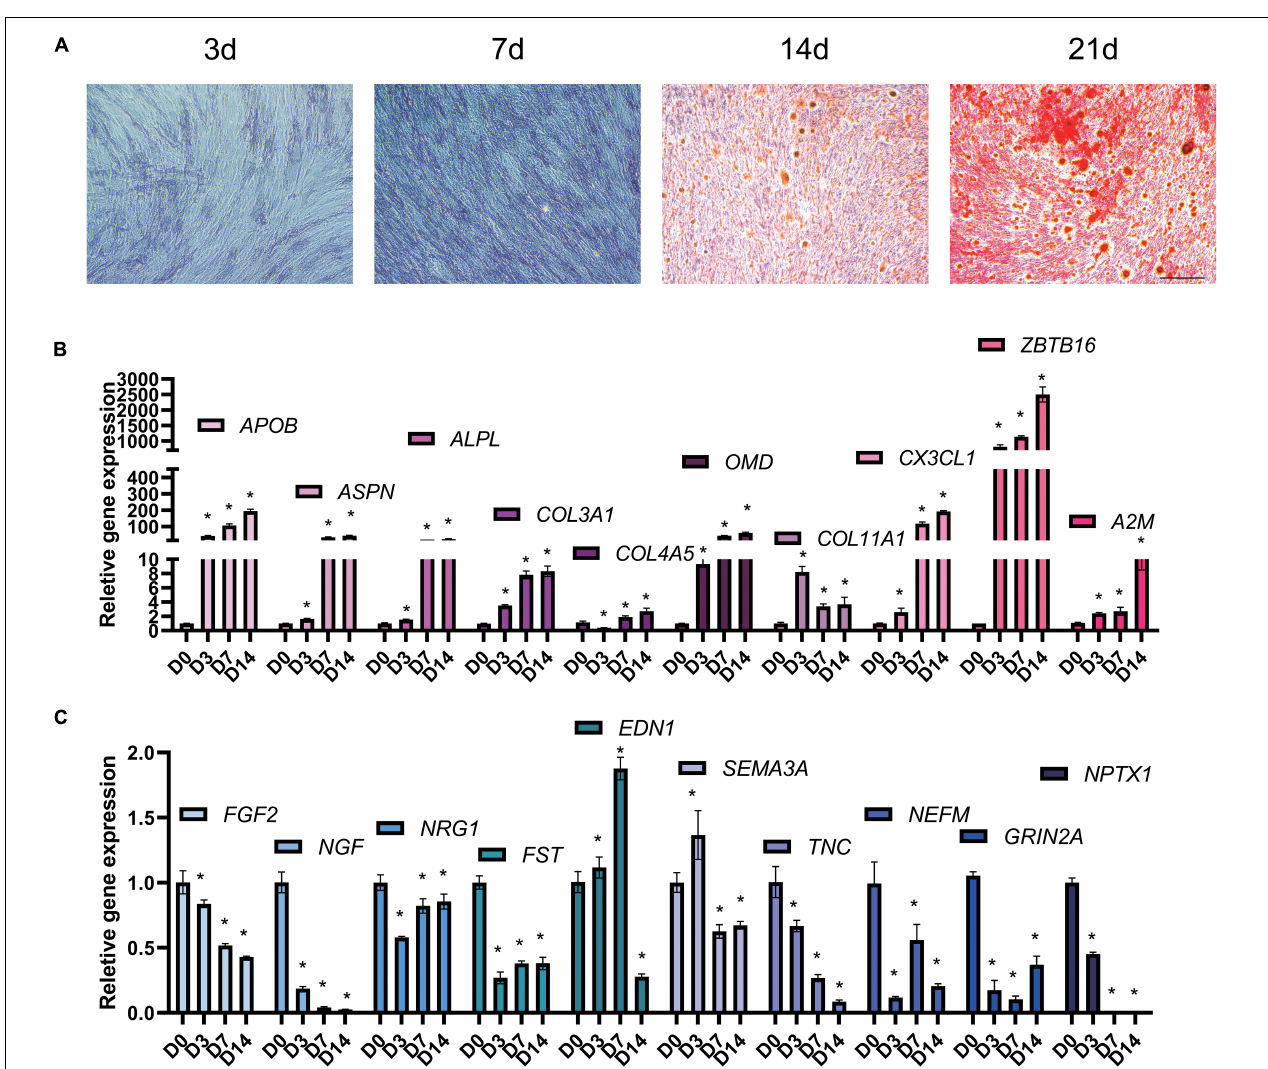
FIGURE 5 | Hub genes change during osteogenic differentiation of PDLSCs in vitro . PDLSCs cells were cultured in osteogenic induction medium for 0, 3, 7, 14 days and tested by qPCR. (A) Representative microscope pictures show results of ALP staining at 3 and 7 days, and the results of Alizarin Red staining at 14 and 21 days. ALP and ARS staining were used to prove that the process of osteogenic differentiation was successful. (B) qPCR results shows up-regulated hub genes APOB, ASPN, ALPL, COL3A1, A2M, COL4A5, OMD, COL11A1, ZBTB16, and CX3CL1 (C) down-regulated hub genes FGF2, NGF, NRG1, FST, EDN1, SEMA3A, TNC, NEFM, GRIN2A, and NPTX1 during osteogenic differentiation of PDLSCs. Bar = 25 µ m. * p <